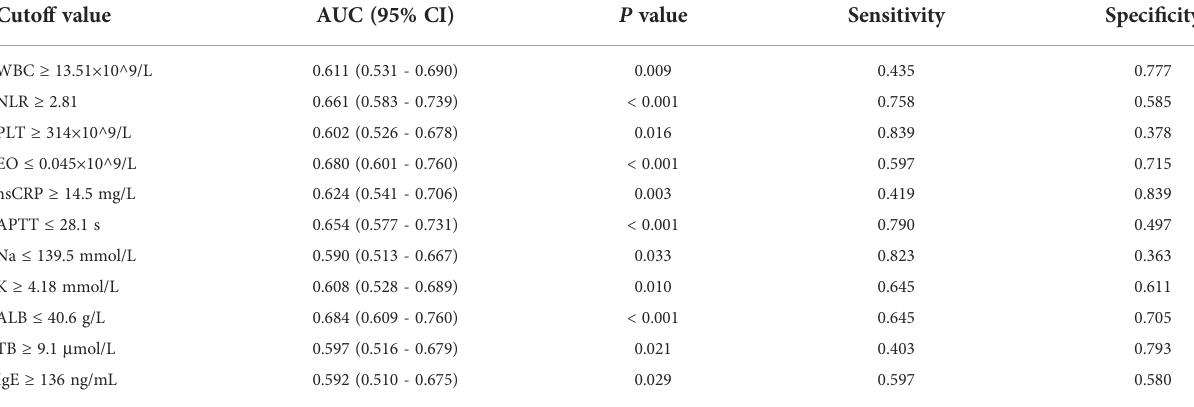
TABLE 3 The cutoff value of converting continuous variables to dichotomous variables in training set. Cutoff